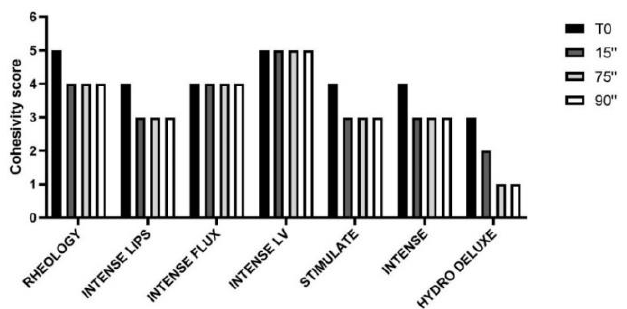
Figure 6. Cohesivity score assigned to six HA dermal fillers cross-linked with PEGDE and a HA non cross-linked dermal filler (18 mg/mL), at different time intervals, according to the Gavard–Sundaram Cohesivity Scale [2]: 1 . fully dispersed; 2 . mostly dispersed; 3 . partially dispersed, partially cohesive; 4 . mostly cohesive; 5 . fully cohesive.